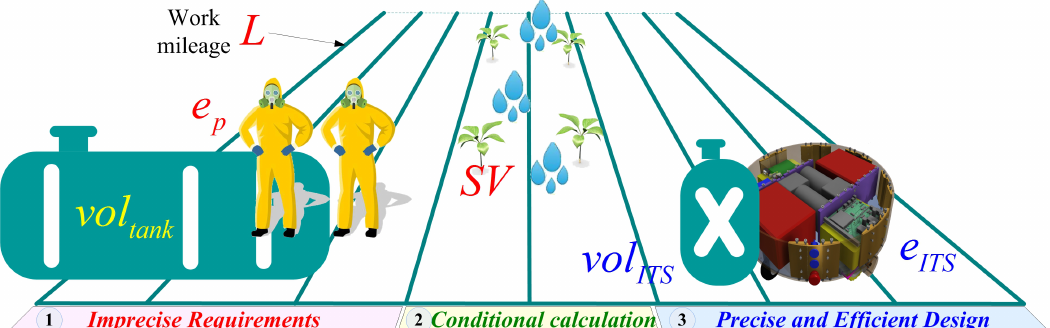
Figure 2. Process between requirements and